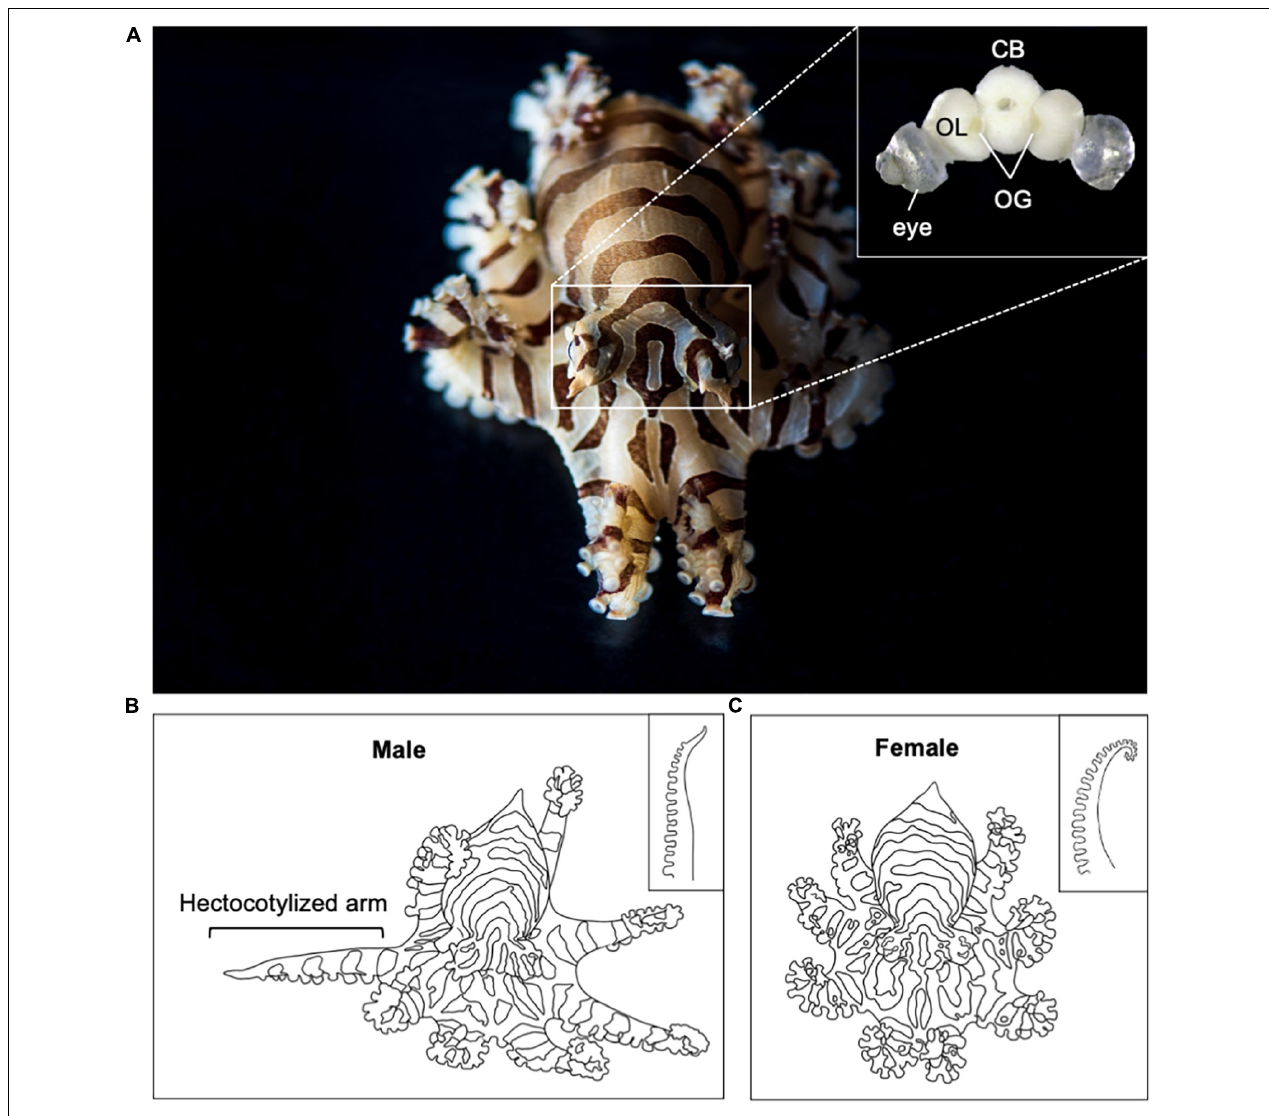
FIGURE 1 | Adult Octopus chierchiae . (A) Dorsolateral view of an adult O. chierchiae, an iteroparous species of octopus native to the Pacific coast of North and Central America. Visual stripes are present 7–14 days after hatching and can be used to distinguish individuals. Inset depicts central nervous system with eyes attached. Two large, kidney-shaped optic lobes (OL) flank the central brain mass (CB; supraesophageal and subesophageal masses). The optic glands (OG) sit on top of the optic tract between the OL and the CB. (B) Illustration of a male O. chierchiae with the hectocotylized arm extended. Male adult O. chierchiae possess a specialized organ on the tip of the third right arm, the hectocotylus (depicted in inset), which has a smooth, sucker-less, hook-like appearance and is used to pass spermatophores to the female during mating. (C) Illustration of a female O. chierchiae, lacking a hectocotylized arm. Female adult O. chierchiae possess suckers along the full length of all arms (depicted in inset). Image A courtesy of Tim